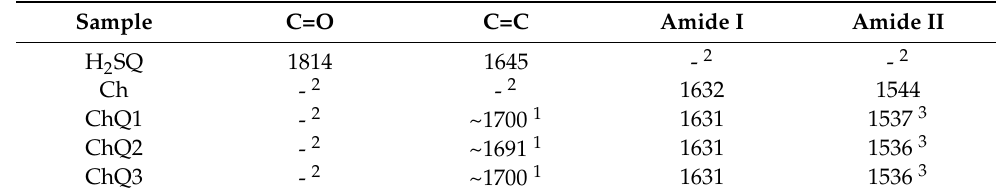
Table 1. The position of characteristic bands [cm − 1 ] in the FTIR spectra of H 2 SQ powder, and Ch- and squaric acid-modified chitosan films. Sample C=O C=C Amide I Amide